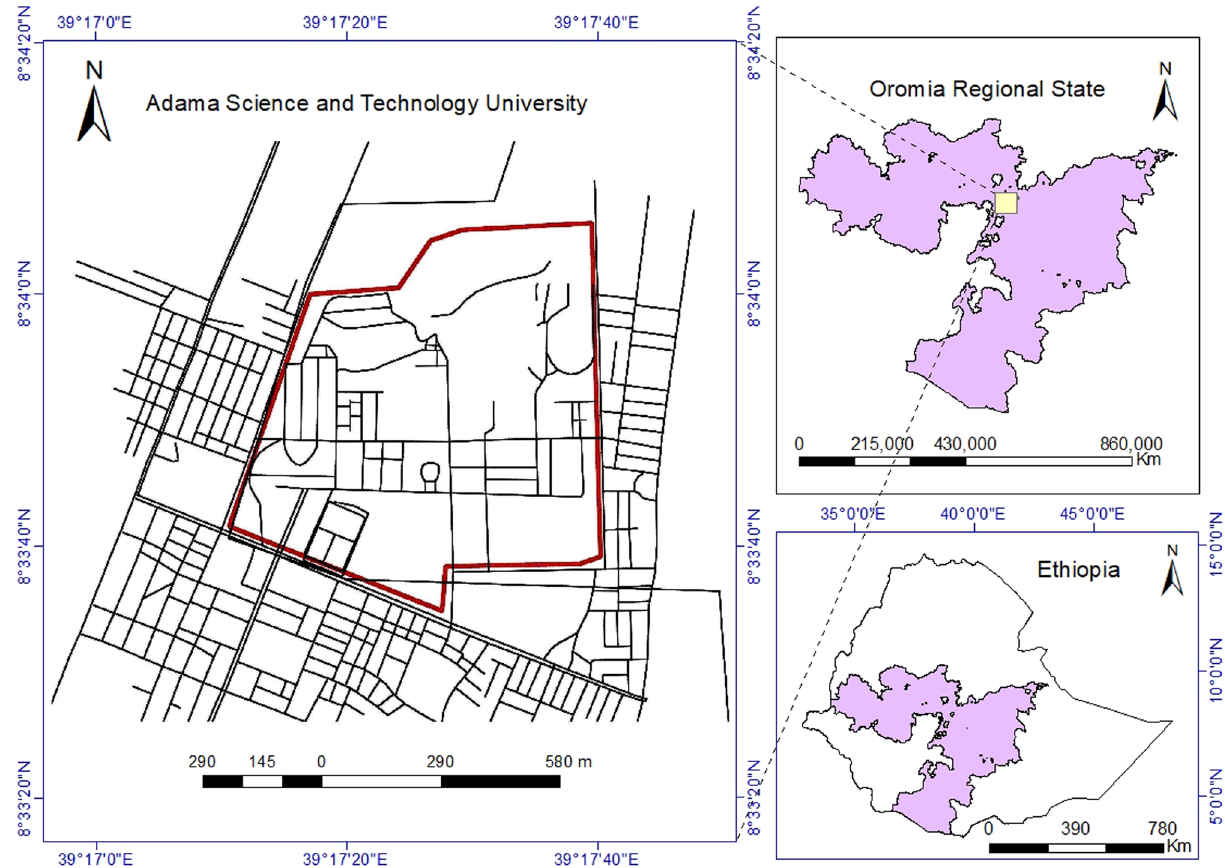
Fig. 1 Location map of the study